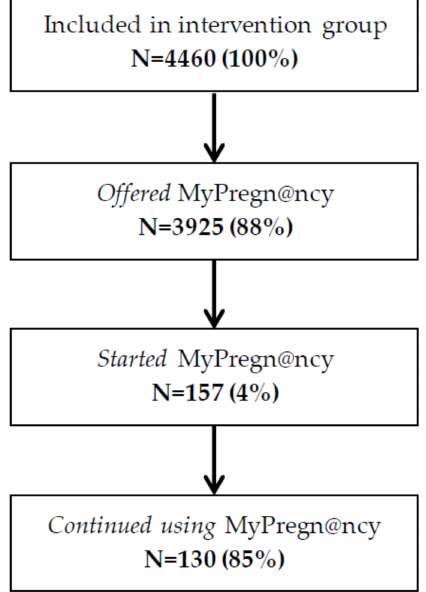
Figure 2. Uptake of the MyPregn@ncy intervention.